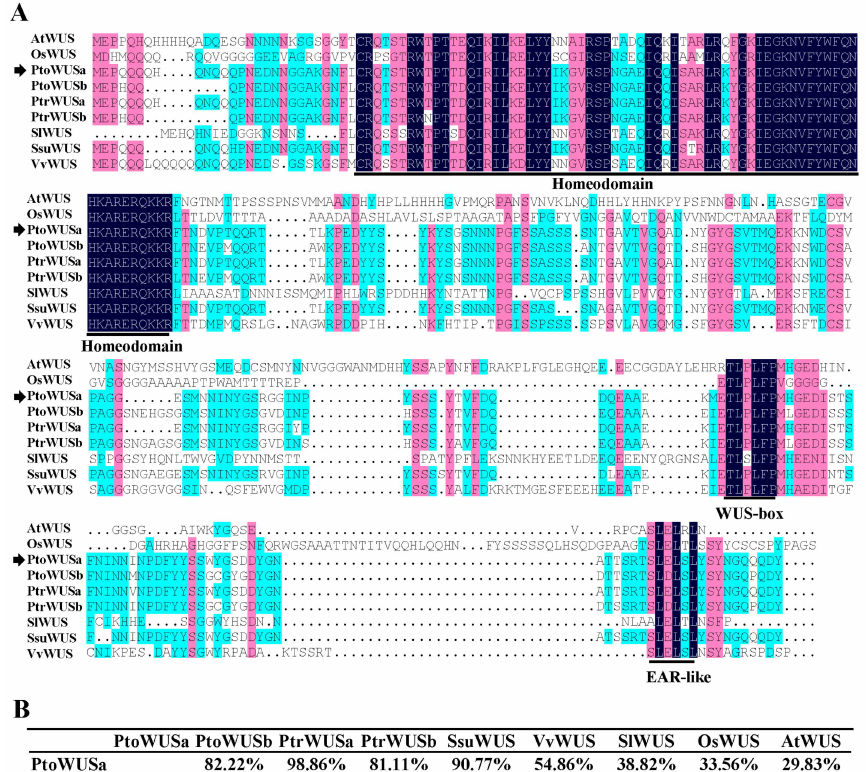
Figure 1. PtoWUSa was highly conserved in a broad range of plant species. ( A ) Amino acid sequence alignment of PtoWUSa with AtWUS ( Arabidopsis thaliana ), OsWUS ( Oryza sativa ), PtrWUS ( Populus trichocarpa ), SlWUS ( Solanum lycopersicum ), SsuWUS ( Salix suchowensis ), and VvWUS ( Vitis vinifera ) orthologous genes in other plant species. The conserved regions (homeodomain, WUS-box motif, and ethylene-responsive element binding factor associated amphiphilic repression (EAR)-like domain) were underlined. ( B ) WUS amino acid sequence